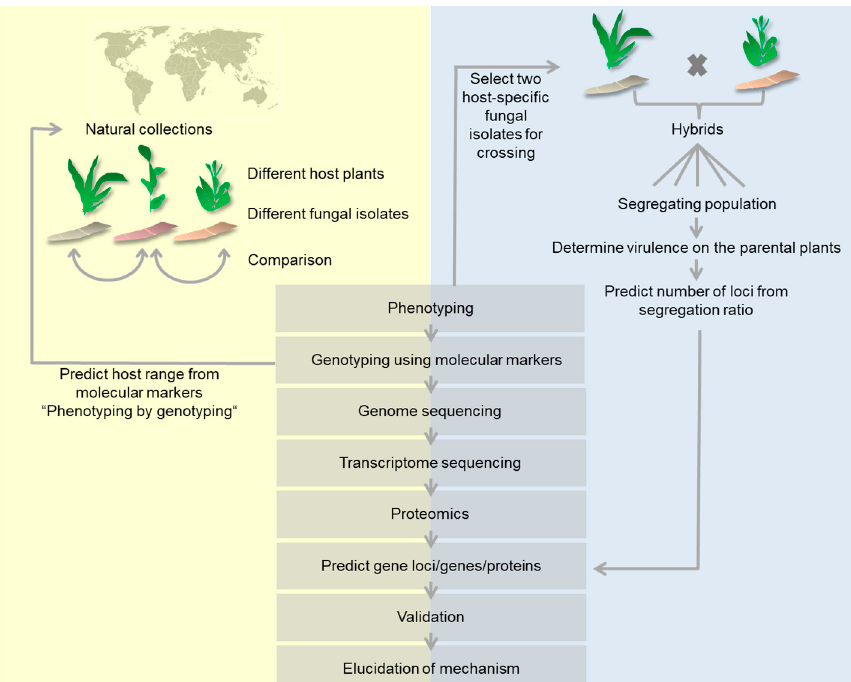
Figure 1. Graphical representation of comparative methods used to determine molecular host-specificity determinants. Methods starting with a collection of natural fungal isolates (yellow background) are contrasted to methods starting with segregating populations of defined strains (gray background). Both starting materials use the same set of analyzing methods.